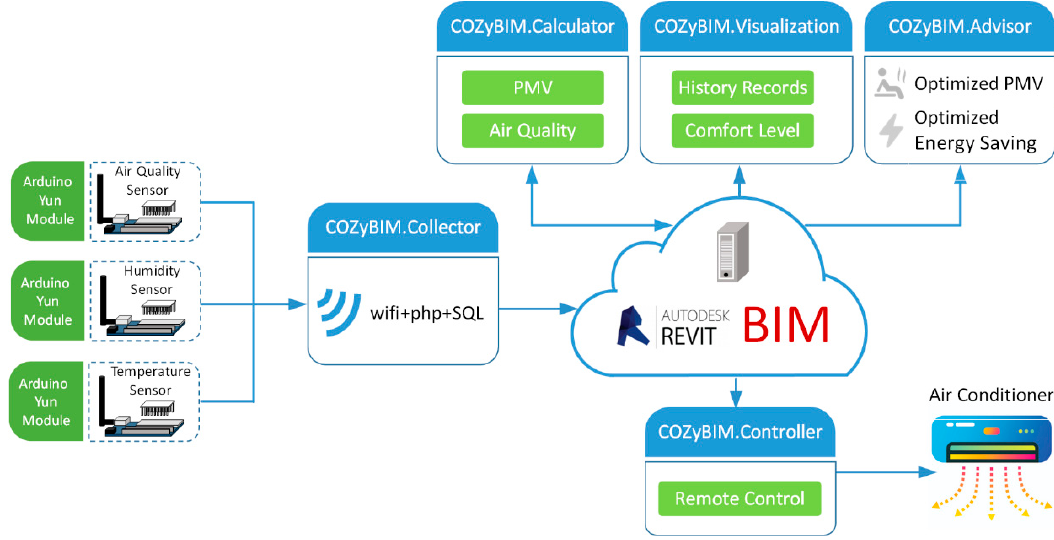
Figure 2. COZyBIM system architecture diagram.